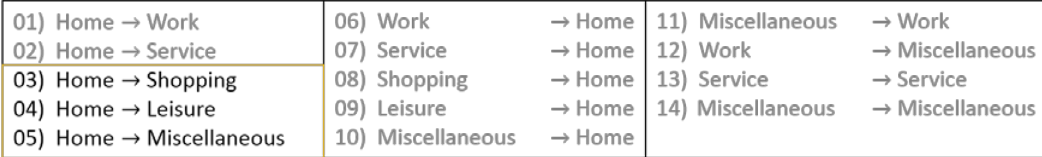
Figure 4. Given OD matrices differing in trip purpose.